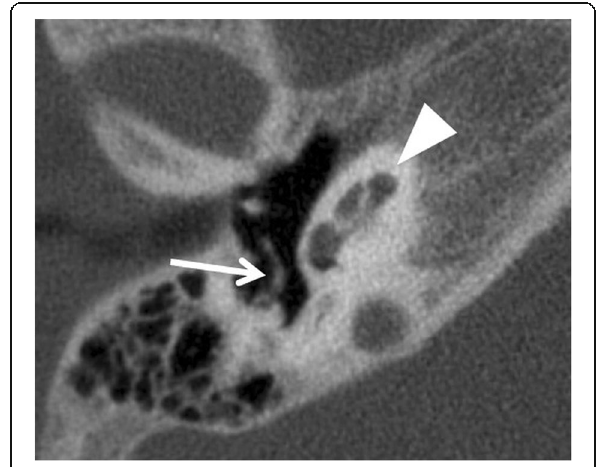
Fig. 7 A 5-year-old male patient, with CHARGE syndrome and bilateral severe SNHL from birth. HRCT axial image shows hypoplastic cochlea type III with less than 2 turns (arrowhead). Malformed crus longum incudis and stapes are fused with the posterior tympanic wall